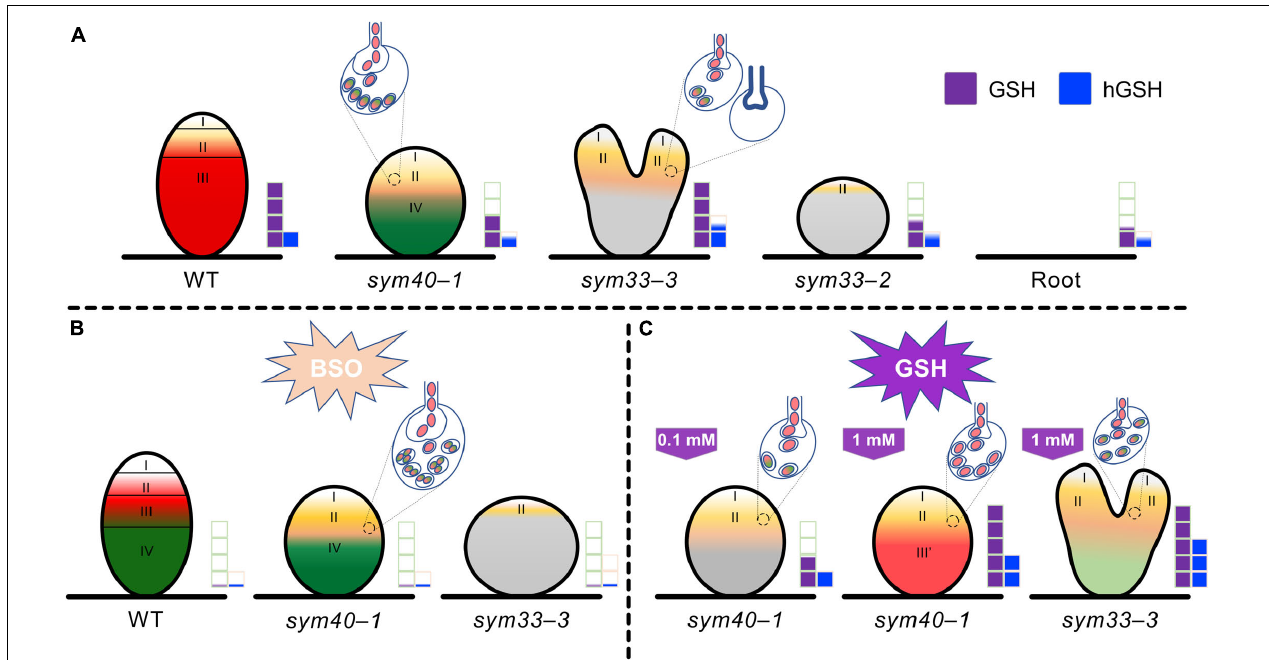
FIGURE 13 | Changes in glutathione (GSH) and homoglutathione (hGSH) content affect the development of infection threads, infection droplets, and symbiosomes in pea ( Pisum sativum ) symbiotic nodule. (A) The effect of changes in GSH and hGSH content was analyzed in wild-type (WT) nodules and nodules of mutants defective in infection thread, infection droplet, and symbiosome development. sym40-1 mutant nodules are characterized by formation of hypertrophied infection droplets, abnormal bacteroids, an early senescence. The sym33-3 mutant has a leaky phenotype. Most cells in white nodules are filled with “locked” infection threads, but bacterial release occurs in some cells of some nodules. The sym33-2 mutant manifests a severe phenotype characterized by formation of a highly branched network of “locked” infection threads arrested in the root outer cortex. Each genotype showed a specific thiol composition in nodules. In all genotypes, the GSH concentration was significantly higher in nodules than in roots. Among all the nodules, those of the sym33-2 and sym40-1 mutant displayed the lowest GSH and hGSH concentration. In sym33-3 nodules, GSH levels were comparable to those of wild-type, while the hGSH content was higher. Compared with roots, the hGSH level was higher in wild-type and sym33-3 nodules, and was unchanged in sym40-1 and sym33-2 nodules. (B) The application of a (h)GSH biosynthesis inhibitor L-buthionine-sulfoximine (BSO) induced (h)GSH deficiency in the roots with nodules. BSO treatment promoted a premature degradation of symbiotic structures at the base and center of the wild-type nodules, indicative of early senescence. The presence of numerous symbiosomes containing several bacteroids was shown in the infected cells of BSO-treated nodules of the sym40-1 mutant. In (h)GSH-depleted sym33-3 nodules meristem development was blocked and infection thread growth was interrupted. (C) An increase in hGSH levels in sym40-1 nodules compared with untreated plants resulting from GSH treatment (0.1 mM) manifested as a restriction of infection and led to a reduction in the size of hypertrophied infection droplets and the number of cells with bacterial release. An increase in the levels of both thiols following GSH treatment (1 mM) nodules led to formation of zone resembling nitrogen fixation zone in wild-type nodule. Treating sym33-3 mutants with GSH led to prominent infection and formation of the structures resembling infection droplets in many nodule cells. However, infection was accompanied by disorganization of released bacteria and enhanced defense responses. Zones of nodule are designated by Roman numerals and colors: I – meristematic zone (white), II – infection zone (ocher), III – nitrogen fixation zone (red), and III (cid:48) – zone corresponding to nitrogen fixation zone in wild-type nodule (reddish), and IV – senescence zone (green). Gray color – nodule parenchyma. Bacteria and bacteroids without signs of degradation are given in red. Degraded bacteroids are given in green. The levels of glutathione and homoglutathione in each genotype are represented by violet and blue squares,